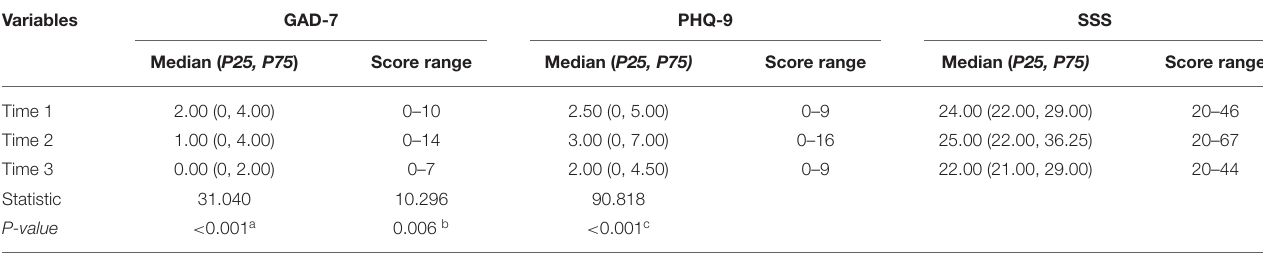
TABLE 2 | Comparison of scores of GAD-7, PHQ-9 and SSS at three stages ( n = 62).